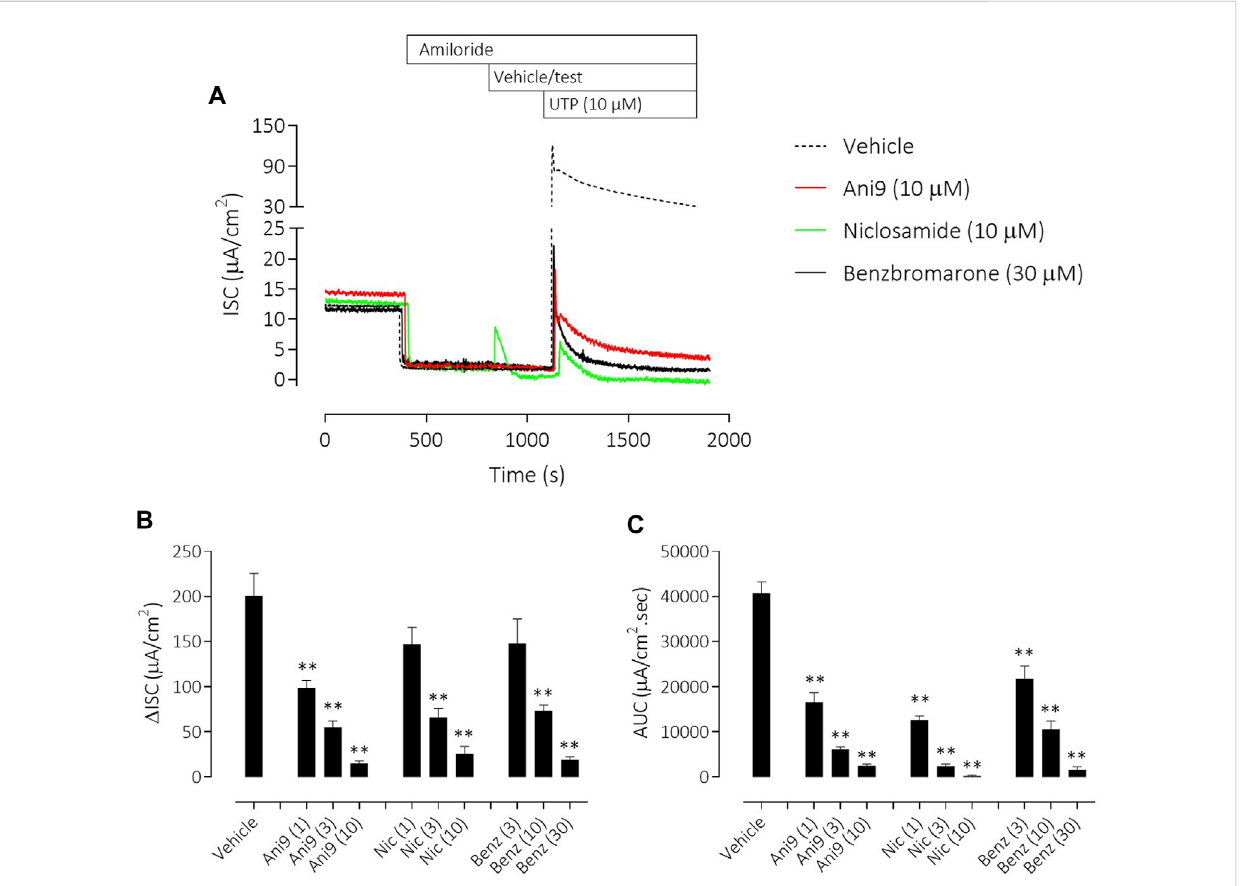
FIGURE 4 Ani9, niclosamide and benzbromarone attenuate UTP-stimulated anion secretion in CF-HBE cells. Sample short-circuit current traces illustrating the effects of Ani9, niclosamide (Nic) and benzbromarone (Benz) on the apical UTP-stimulated response of IL-13 pre-treated CF-HBE cells (A) . The peak increase in ISC (B) as well as the integrated AUC (C) were measured. Mean data ±SEM ( n = 3-5 inserts per group) are shown. Concentrations of test compounds are shown in brackets as µM. ** denotes p < 0.0001 respectively following a one-way ANOVA using post hoc Dunnett ’ s